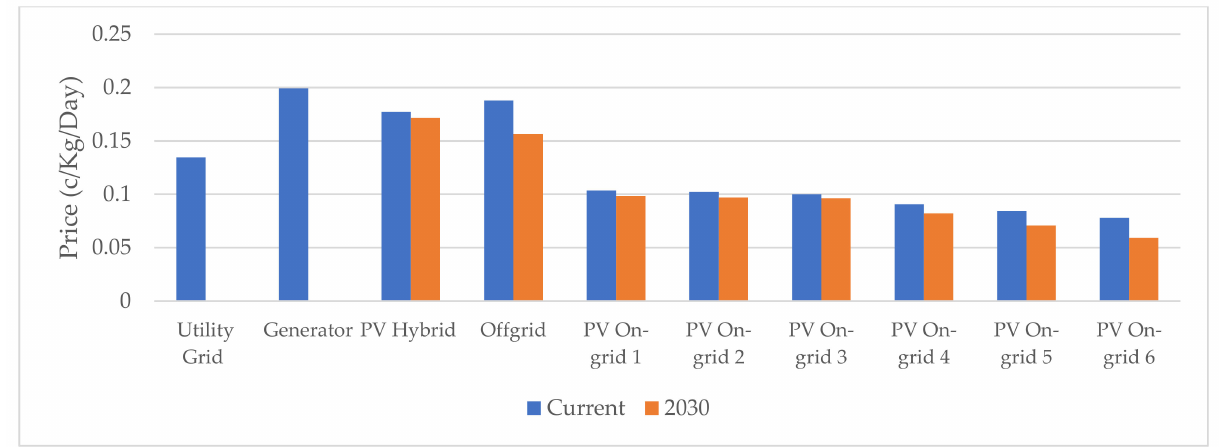
Figure 16. Rental Prices Community-based Cold Storage in